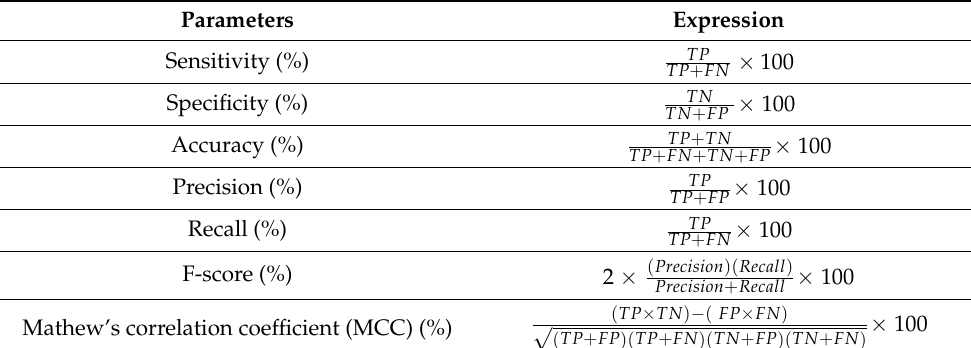
Table 5. Performance Metrics.